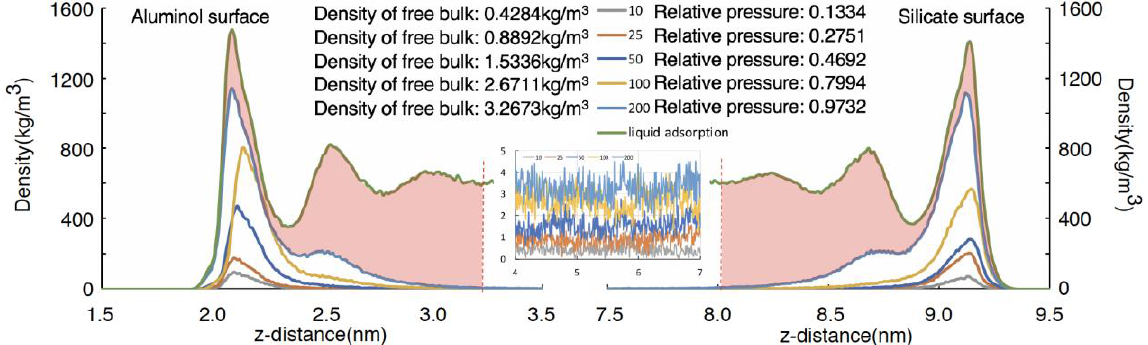
Figure 6. Adsorption density curve of liquid n-pentane and gaseous n-pentane at different relative pressures.